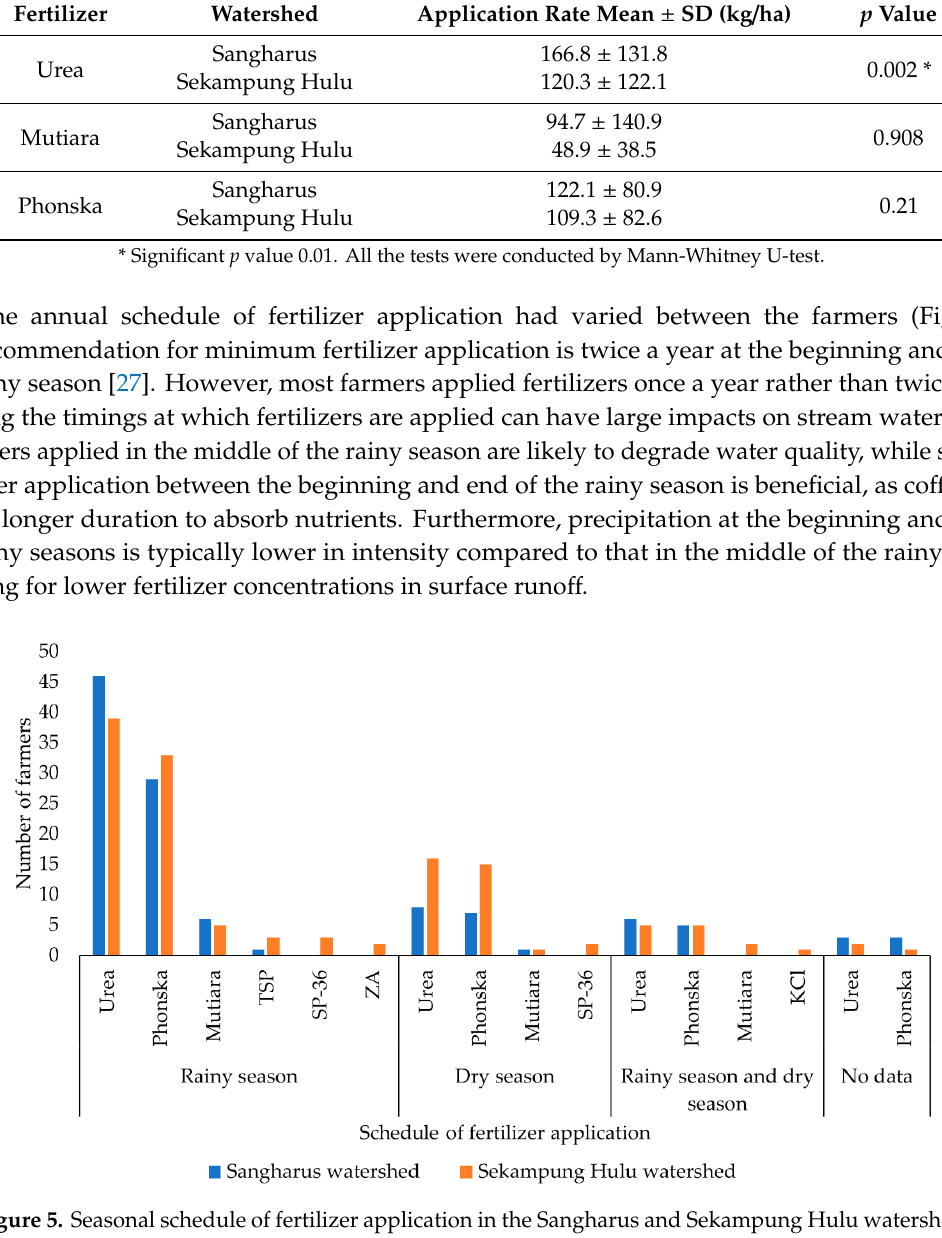
Table 4. Urea, mutiara, and phonska applications in the Sangharus and Sekampung Hulu watersheds. Fertilizer